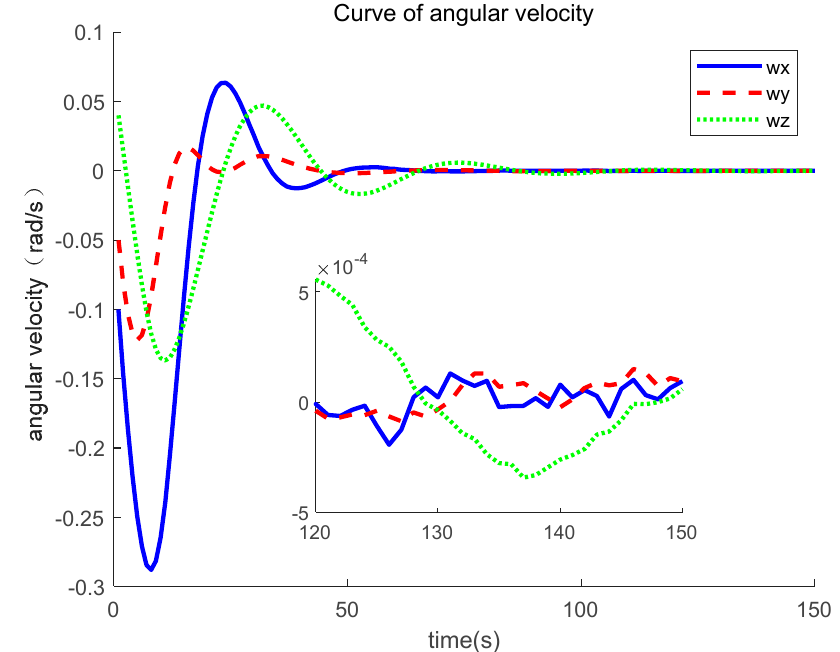
Figure 1. Curve of angular velocity under a standard PID controller.